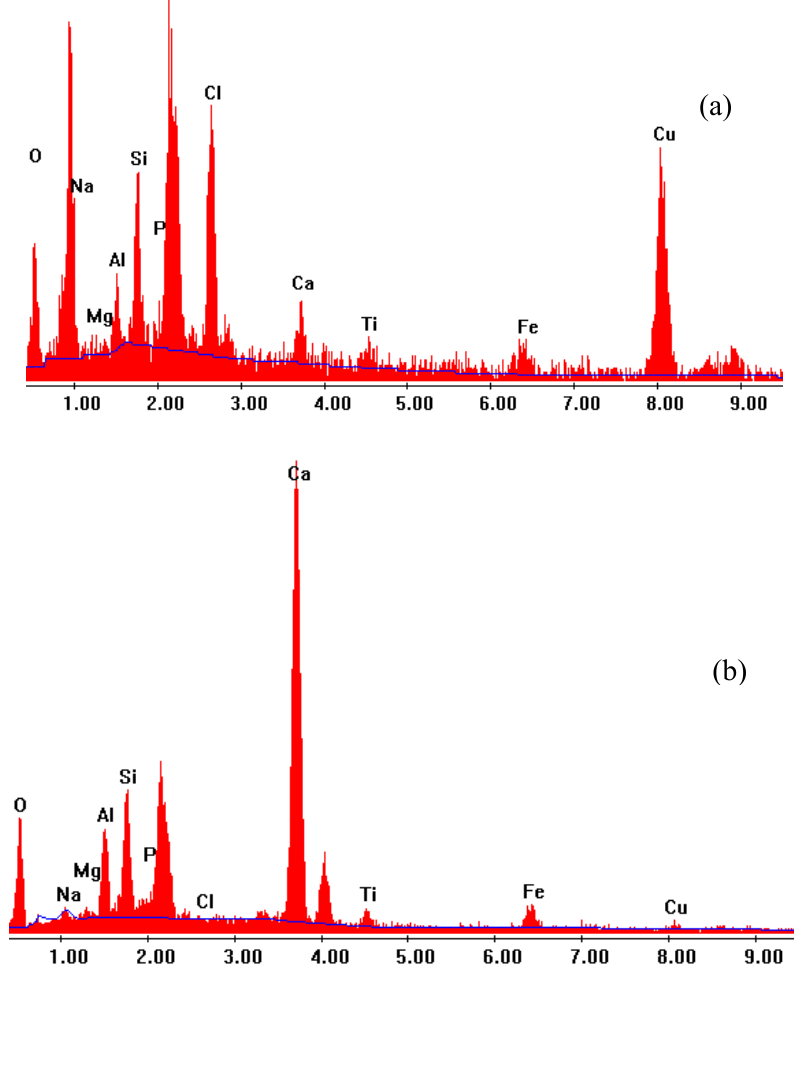
Figure 5. EDS graphs showing peaks of major elements detected for ( a ) blue precipitates (at Cu dose of 61,875 mg/L) and ( b ) the original GR